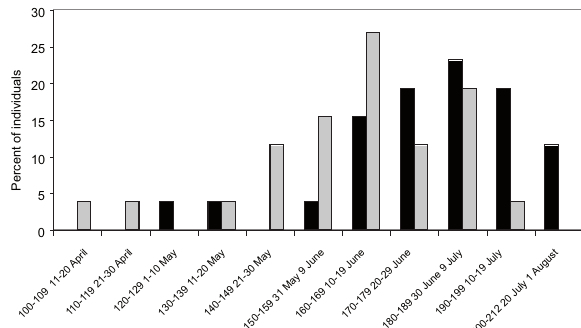
Fig . 5. – Birth date distribution comparing the two methods of read- ing in the postrostrum using x10 amplification. Solid bar (IMR), spotted bar (GBR). The horizontal axis represents days in Julian calendar days and